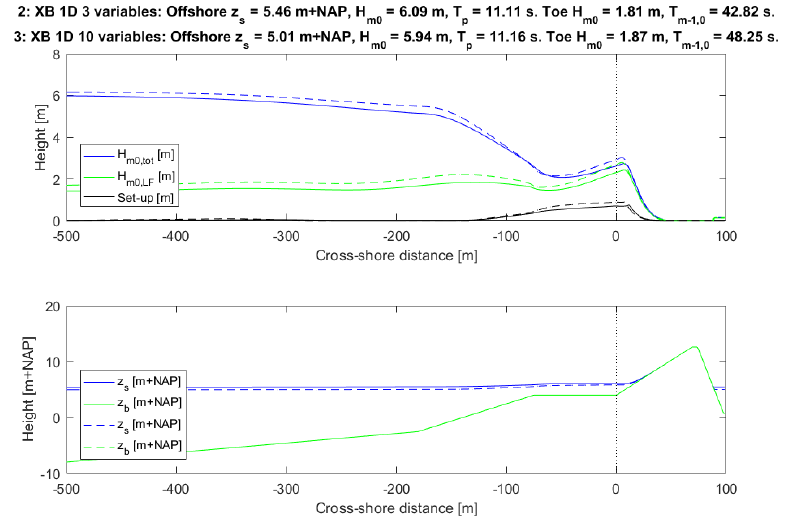
Figure 8. XBeach 1D calculations with 3 (solid lines) and 10 (dashed lines) stochastic variables at the design point. The dike toe is indicated by the dotted line. The parameters offshore and at the toe of the dike are given in the title of the figure.